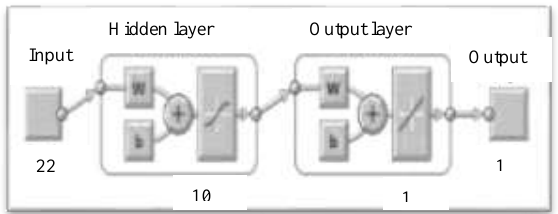
Figure 1. Model of back-propagation neural network (BP) .